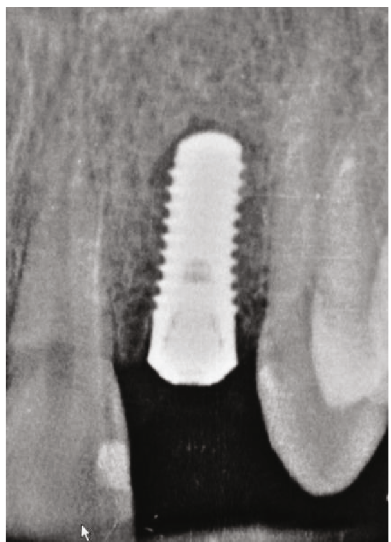
Figure 5: Postoperative X-ray.